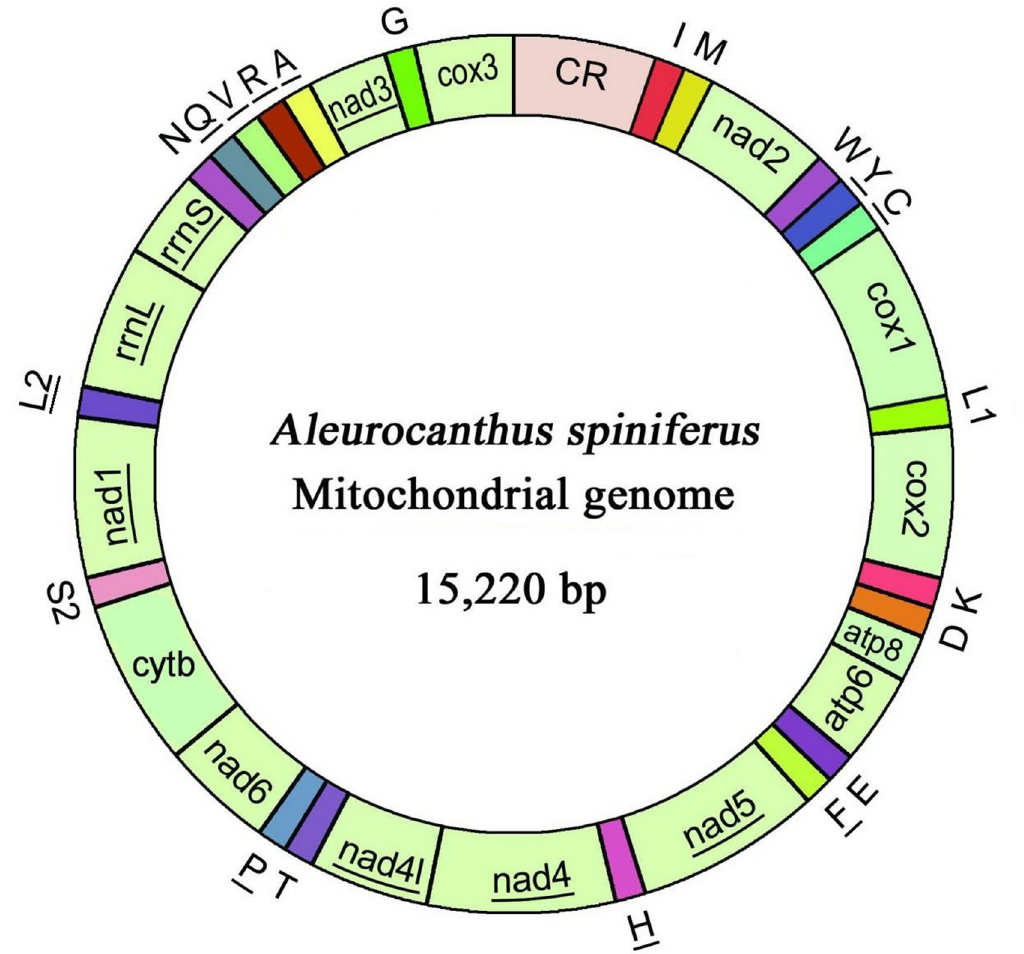
Fig 1. Mitochondrial map of A . spiniferus . Genes that are not underscored are transcribed on the majority strand (J- strand; an exception is the control region, CR). Genes that are underscored are transcribed on the minority strand (N- strand). tRNA genes are designated by single letter amino acid codes outside the